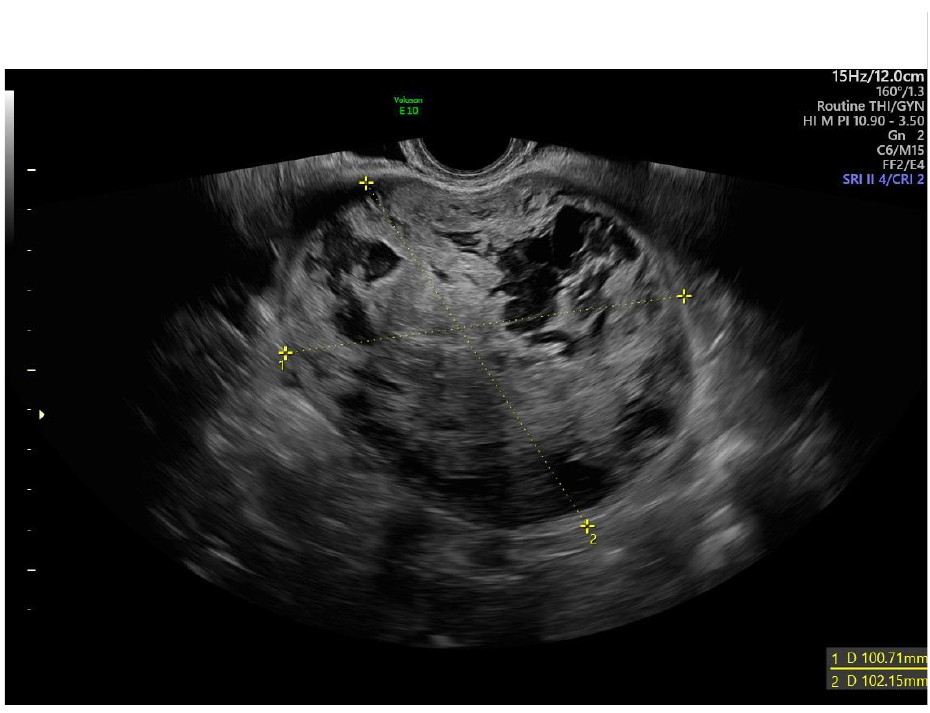
Figure 2. Transvaginal ultrasound of a myoma with irregular cystic areas.